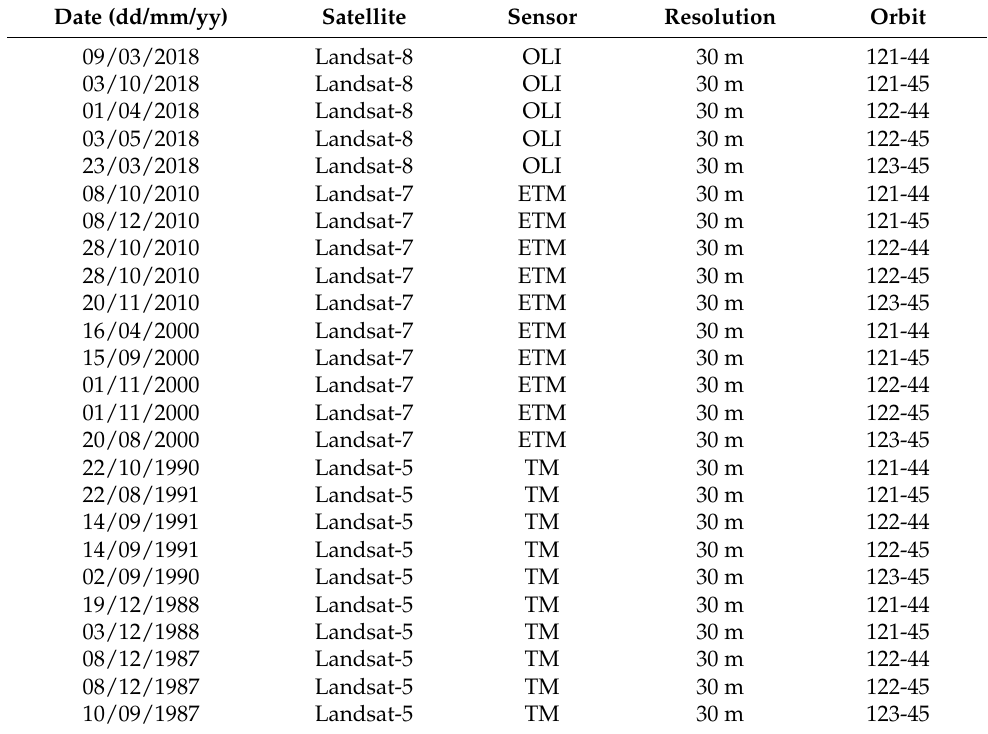
Table 1. Remote sensing data.